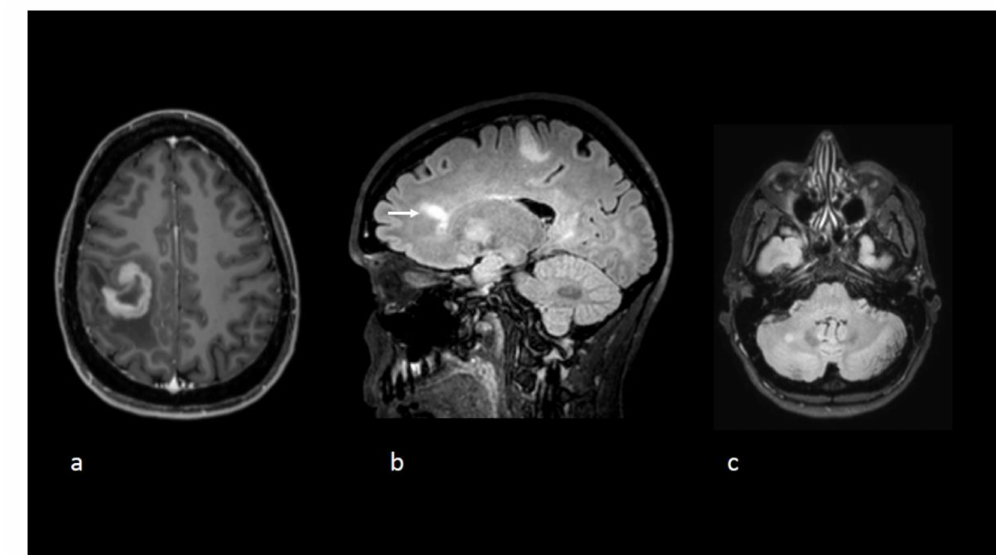
Figure 1. Axial T1-weighted postgadolinium image ( a ) reveals a tumefactive lesion centred on the central sulcus with a thick open-ring enhancement pattern before initiation of natalizumab. Sagittal ( b ) and axial ( c ). Fluid-attenuated inversion recovery (FLAIR) sequences show other nonenhancing lesions including one with a Dawson’s fingers appearance (white arrow).